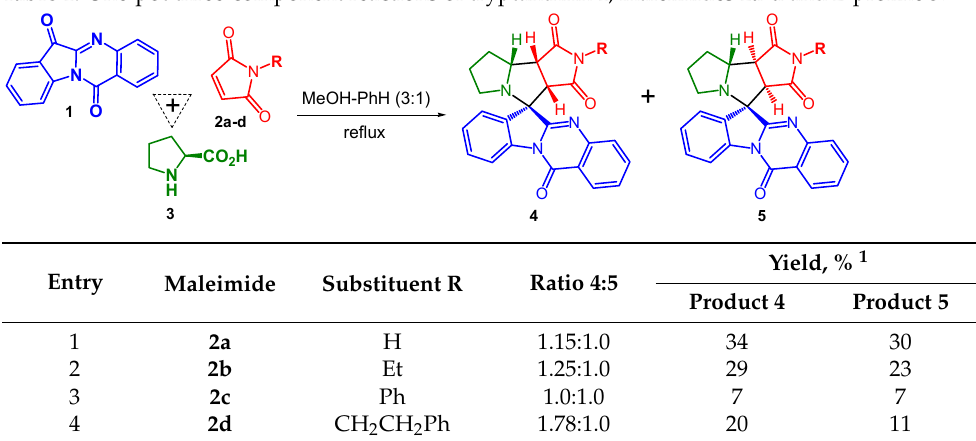
Table 1. One-pot three-component reactions of tryptanthrin 1 , maleimides 2a-d and L -proline 3 .